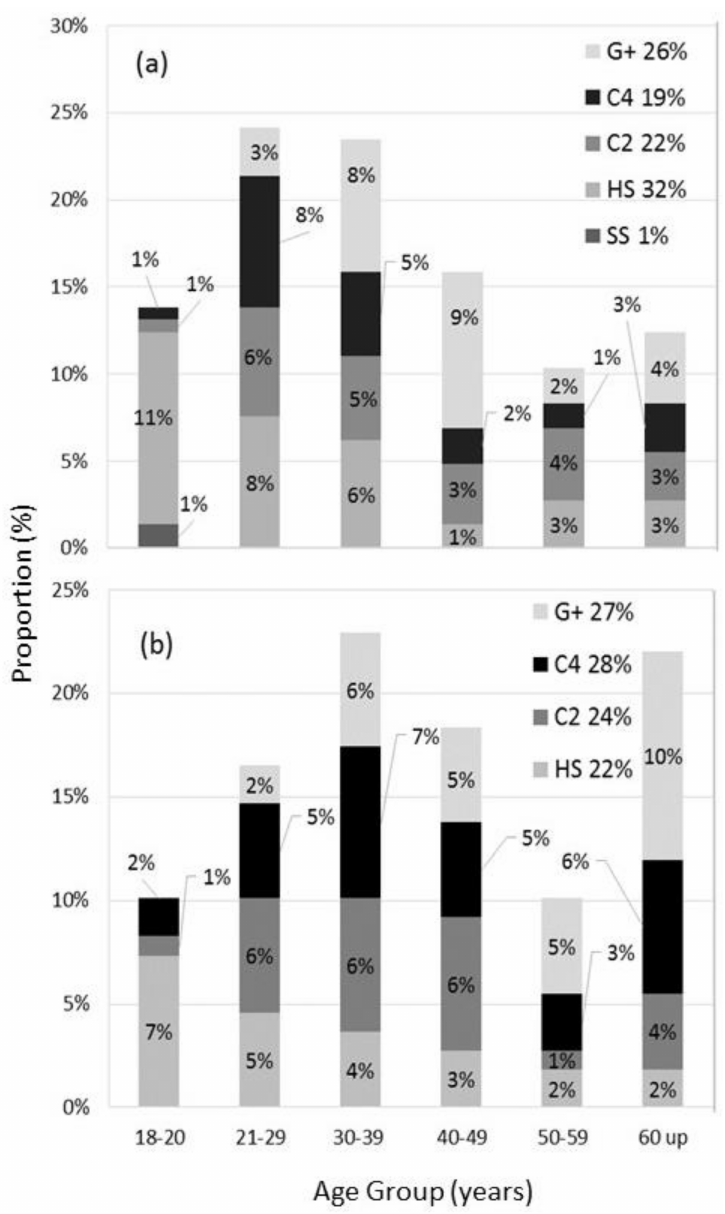
Figure 3. Composition of surveyed visitors (population %) for female ( a ) and male ( b ) by age and education. SS: Secondary school, HS: High school, C2: two-year college, C4: four-year college,